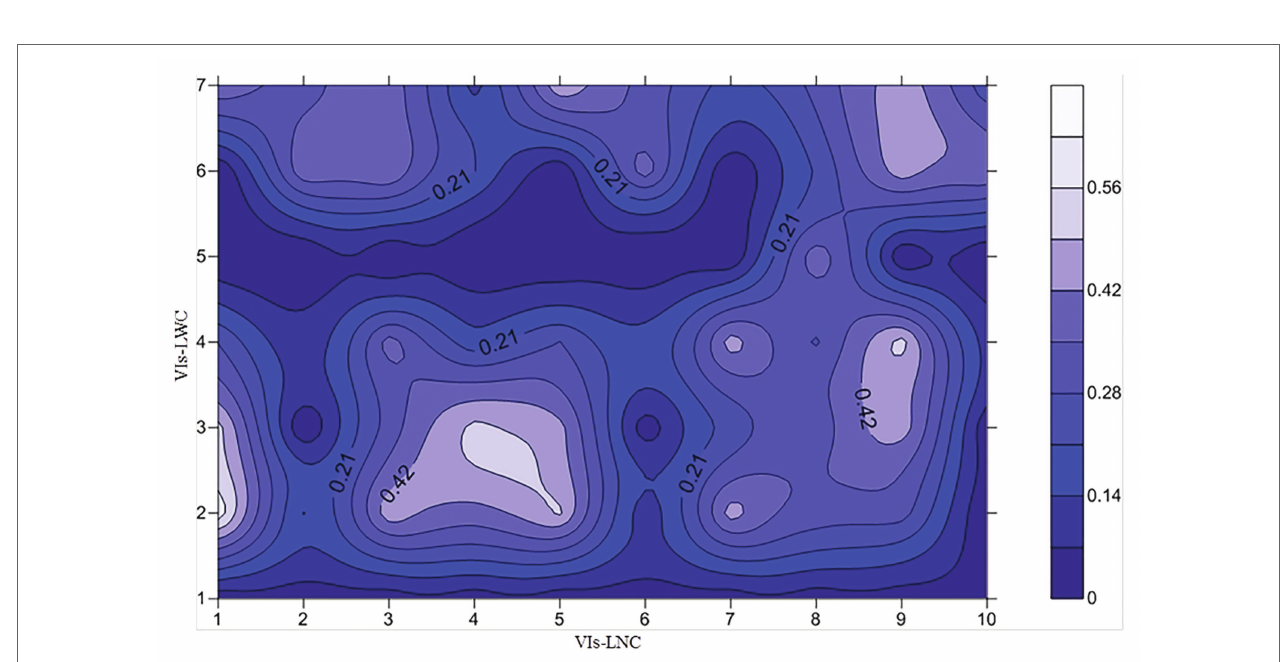
FIGURE 4 | Correlations between different parameter ratios and the WUE. [X-axis: VIs-LNC (vegetation indices related to LNC) 1–10 represent NDDAigig, R 434 / (R 496 + R 401 ), R 705 /(R 717 + R 491 ), SRPI, NDRE, Lo, NRI, NDGI, RES, MCART (700, 670, and 550), respectively; Y-axis: VIs-LWC (vegetation indices related to LNC) 1–7 represent PRI (570 and 531), FWBI, WBI-1, WI, Vari-GREEN, mSR705, NDVI (895 and 675), respectively; n =